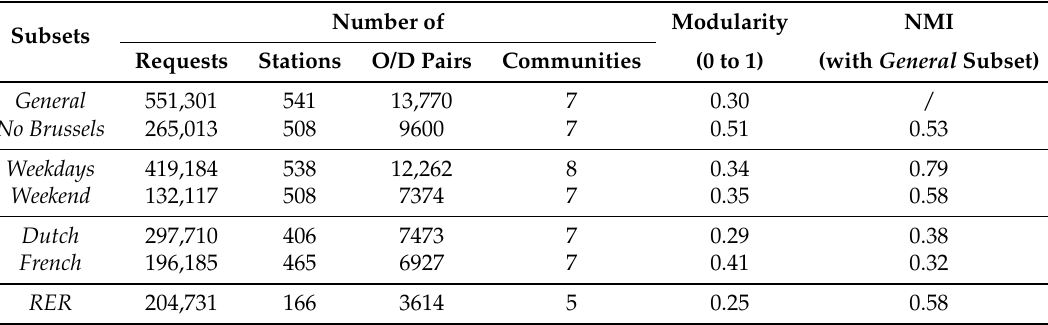
Descriptive statistics of the subsets. NMI, normalized mutual information;